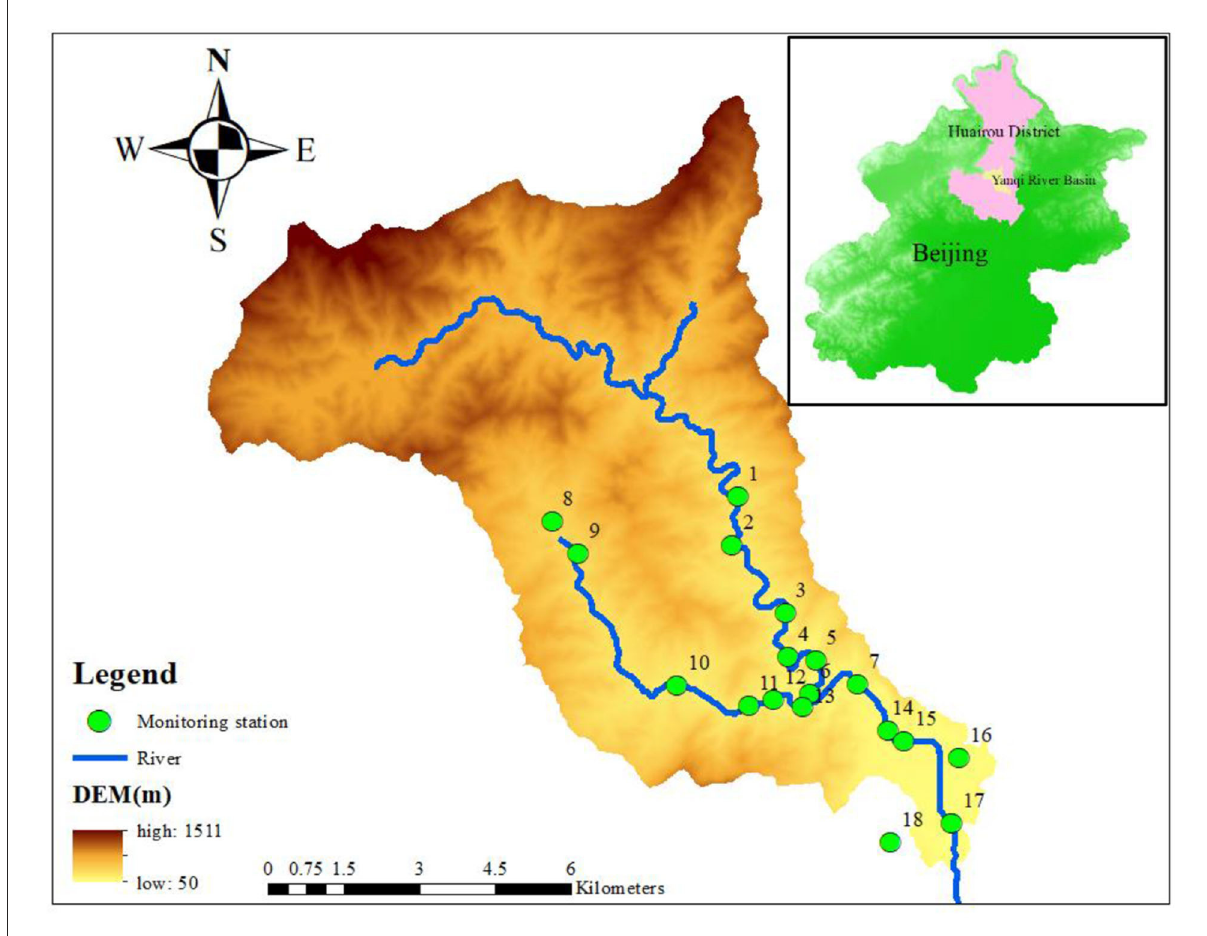
FIGURE10 The location of Yanqi River